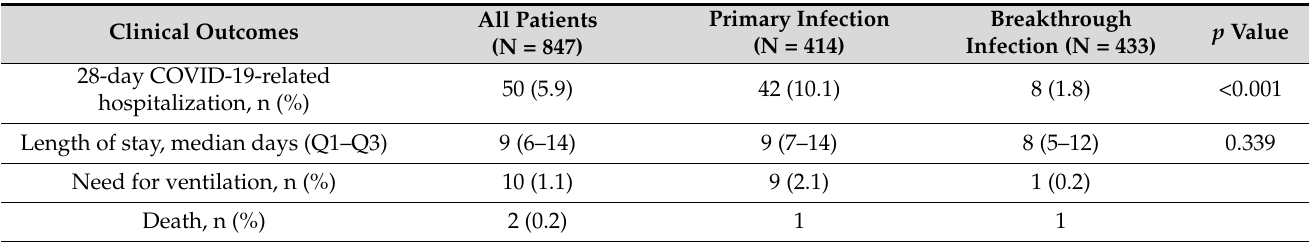
Table 2. Primary and secondary outcomes in the total population and by infection